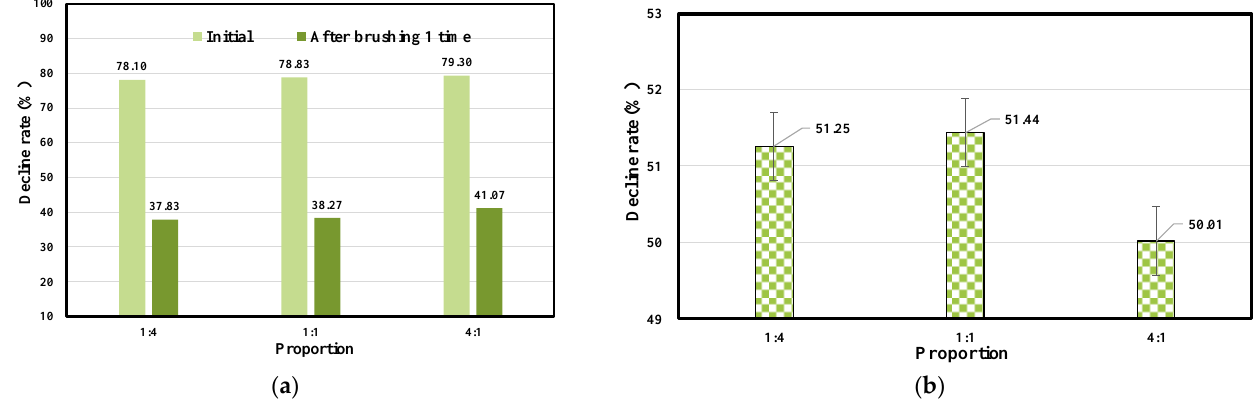
Figure 9. Design 3: ( a ) the change in the reflection rate and ( b ) the decline rate (different ratios of associating thickener and non-associating thickener).